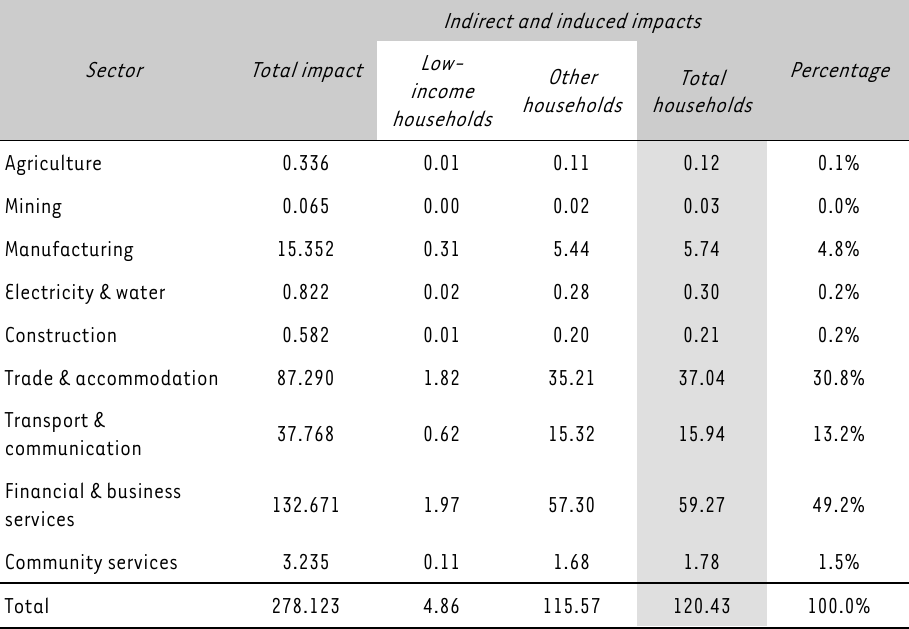
Indirect and induced impacts Percentage Low- Other Total income households households households